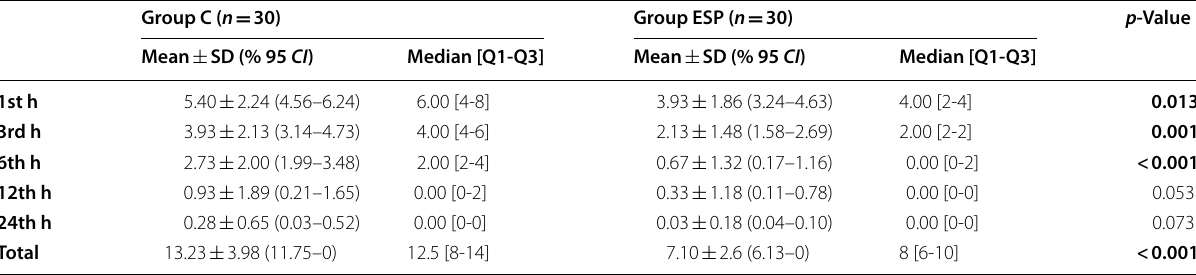
Note: Data are expressed as mean standard deviation (95% CI) and median ([IQR, Q1–Q3]). Statistically significant difference is highlighted in bold ±